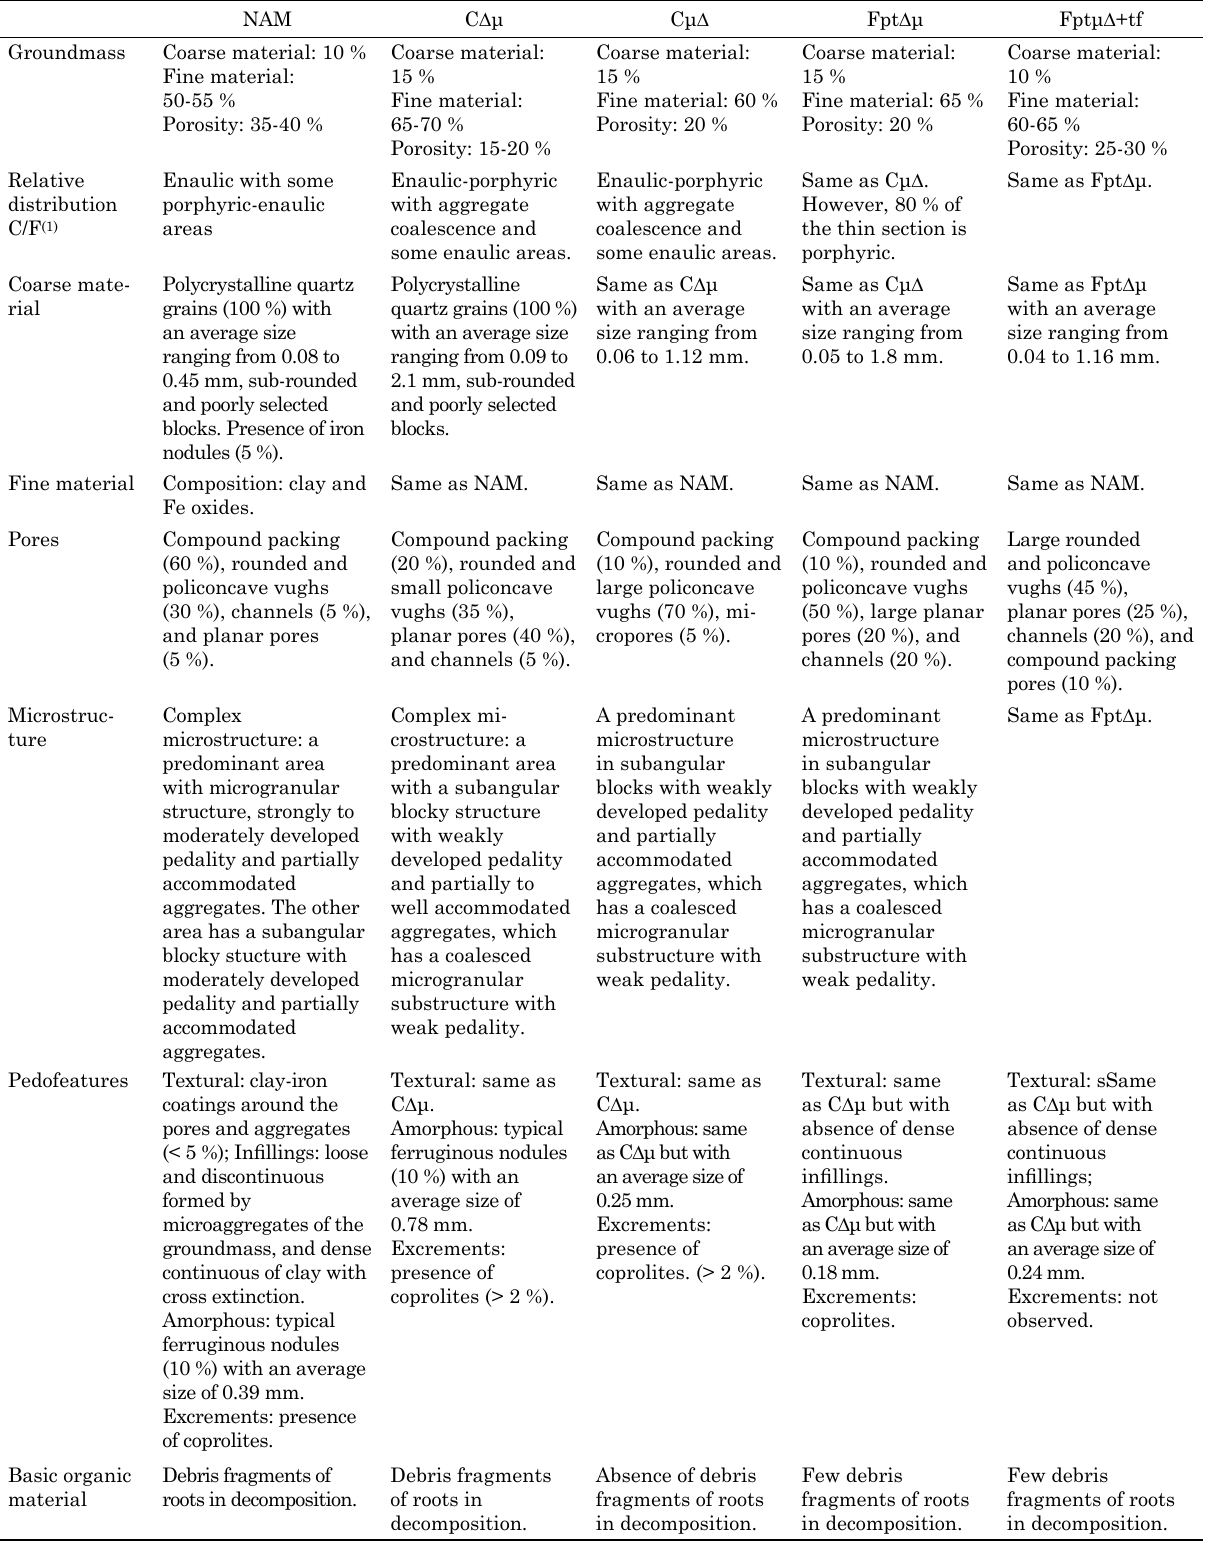
Table 2. Micromorphological characteristics of morphologically homogeneous units (MHUs) of the crop profile under the Conventional System (CS)